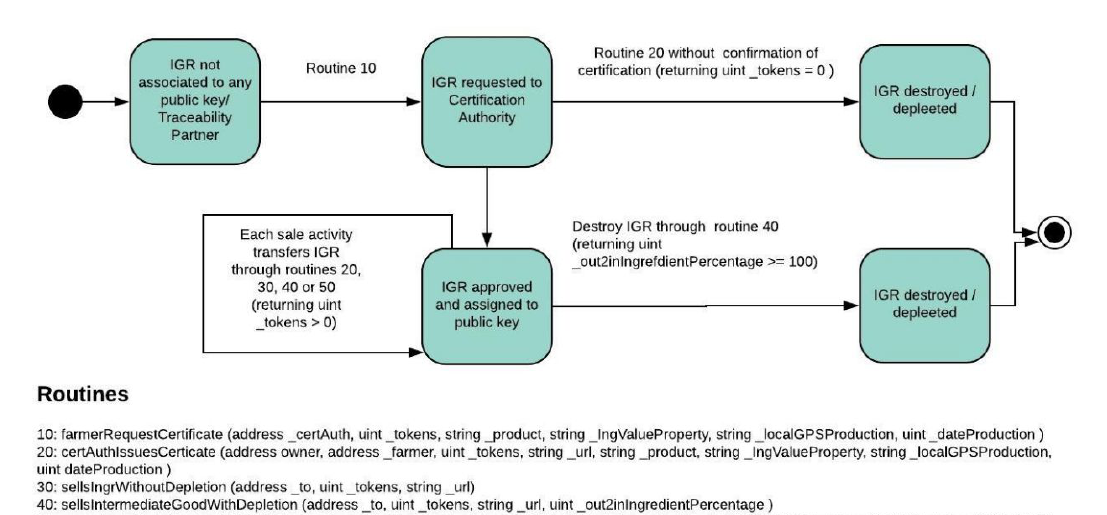
Figure 7. IGR token Transition Diagram showing token states as triggered by smart contracts.